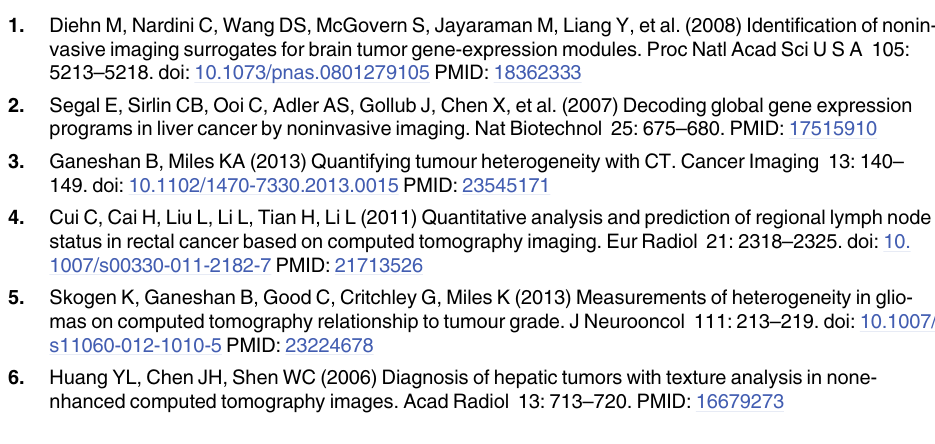
S1 Fig. Selected linear regression plots of texture features with respect to protein expression levels. The 95% confidence interval is rendered. S1 Table. Hypoxia related markers and immunohistochemical staining data. S2 Table. Imaging features definitions. S3 Table. Relationship between texture features and protein expression levels by linear